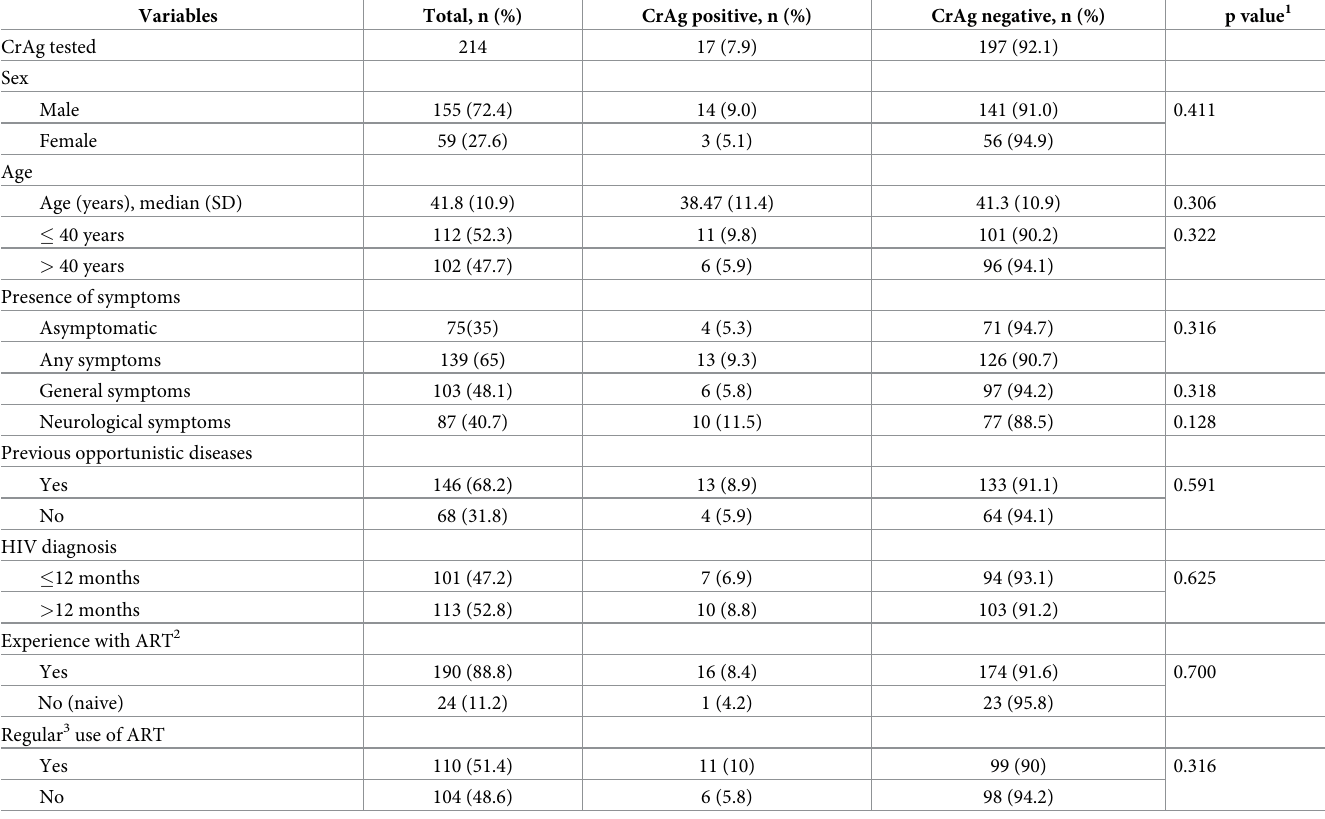
Table 1. Sociodemographic and clinical characteristics of 214 individuals screened for serum